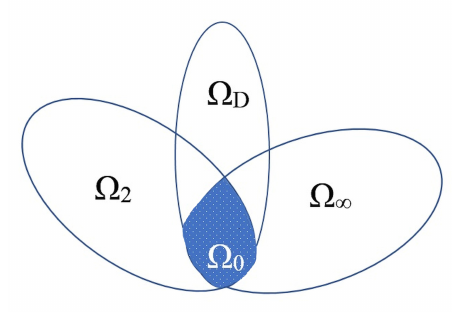
Figure 7. Parameter set Ω 2 , Ω ∞ , Ω D , areas marker is Ω 0